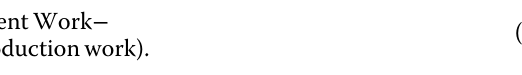
Table 1 Energy analysis results of CO EOR method